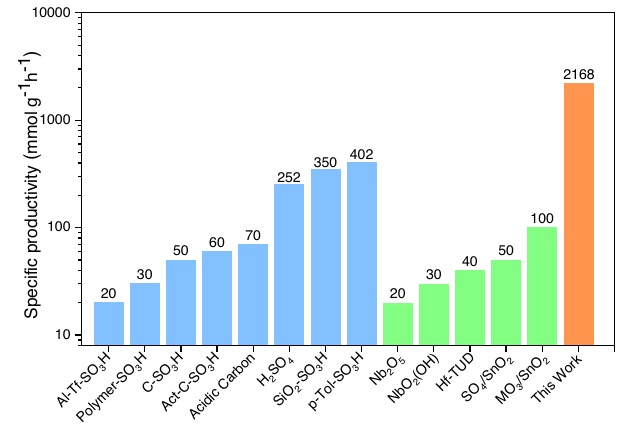
Fig. 5 | The catalyst performance compared to state of the art. Speci fi c pro- ductivity of G-ASA catalyst and previously reported glycerol acetylating hetero- geneous Brønsted acid (blue) and Lewis acid (green) catalyst. (C-SO 3 H 25 , Act-C- SO 3 H 61 ,Al-Tf-SO 3 H 66 ,SiO 2 /SO 3 H 31 ,Polymer-SO 3 H 67 ,AcidicCarbon 40 ,H 2 SO 4 34 ,p-Tol- SO 3 H 34 , Hf-TUD 39 , MO 3 /SnO 2 24 , SO 4 /SnO 2 37 , NbO 2 (OH) 68 , Nb 2 O 5 69